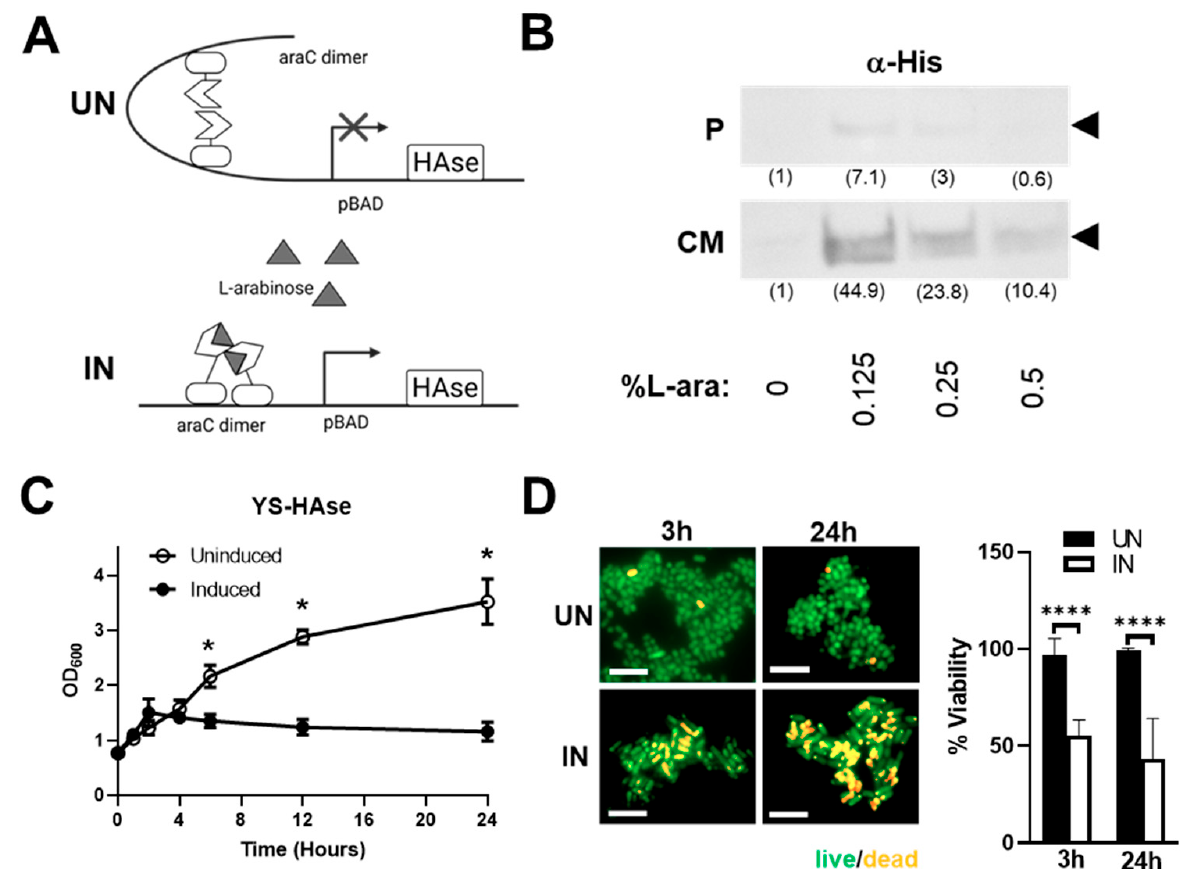
Figure 1. Induction of HAse expression leads to its secretion by YS-HAse and attenuated bacterial growth. ( A ) Schematic of the expression of HAse in pBAD under uninduced (UN, top) and induced (IN, bottom) conditions. ( B ) Attenuated YS1646 transformed with the pBAD-HAse construct (YS- HAse) was cultured in growth media until reaching the log phase (0.7 OD 600 ) and was uninduced (0% L-arabinose) or induced with 0.125–0.5% L-arabinose (L-ara) for 2 hours at 37 ◦ C. The bacterial cell lysates (P) or concentrated culture media (CM) for each L-ara concentration were run on a polyacrylamide gel and subjected to Western blot analysis against a His tag fused to the amino terminus of HAse ( α -His). The relative band density in parentheses (ImageJ) normalized to 0% L-ara. ( C ) The growth curve of YS-HAse post-induction. Optical density readings (OD 600 ) for uninduced and induced (2% L-ara) YS-HAse cultures were measured over 24 hours. Uninduced and induced cultures were done in triplicate, and their growth curves are compared. * p < 0.05, t -test. ( D ) Live/dead staining of uninduced and induced YS-HAse cultures. YS-HAse cultures were grown to the log phase, uninduced (UN) or induced (IN, 2% L-ara), and stained at the indicated timepoints with a 1:1 mixture of acridine orange (live, green) and ethidium bromide (dead, orange) in PBS. Percent viability = (total-dead)/total × 100%. Fluorescent imaging was performed with an Axio Observer 7 (Carl Zeiss) with a 63 × objective (630 × total magnification). Scale bar = 5 µ m. Percent viability of UN and IN YS-HAse is based on 10 random fields. **** p < 0.0001, t -test. To assess the impact of HAse expression on the growth of YS1646, we performed growth kinetic culture studies in the absence or presence of L-ara (Figure 1C). YS-HAse was cultured to the logarithmic phase and uninduced or induced. The optical density (OD 600 ) readings performed at various timepoints over 24 h show that uninduced YS-HAse grows steadily over time, reaching an OD 600 of 2.167 at 6 h and 3.520 by 24 h. Conversely, the induction of YS-HAse significantly impairs its growth, resulting in a 3.2-fold reduction in growth at 24 h compared to the uninduced ( p < 0.05). These data indicate that the expression of HAse is toxic to YS1646, resulting in attenuated growth, death, or both.